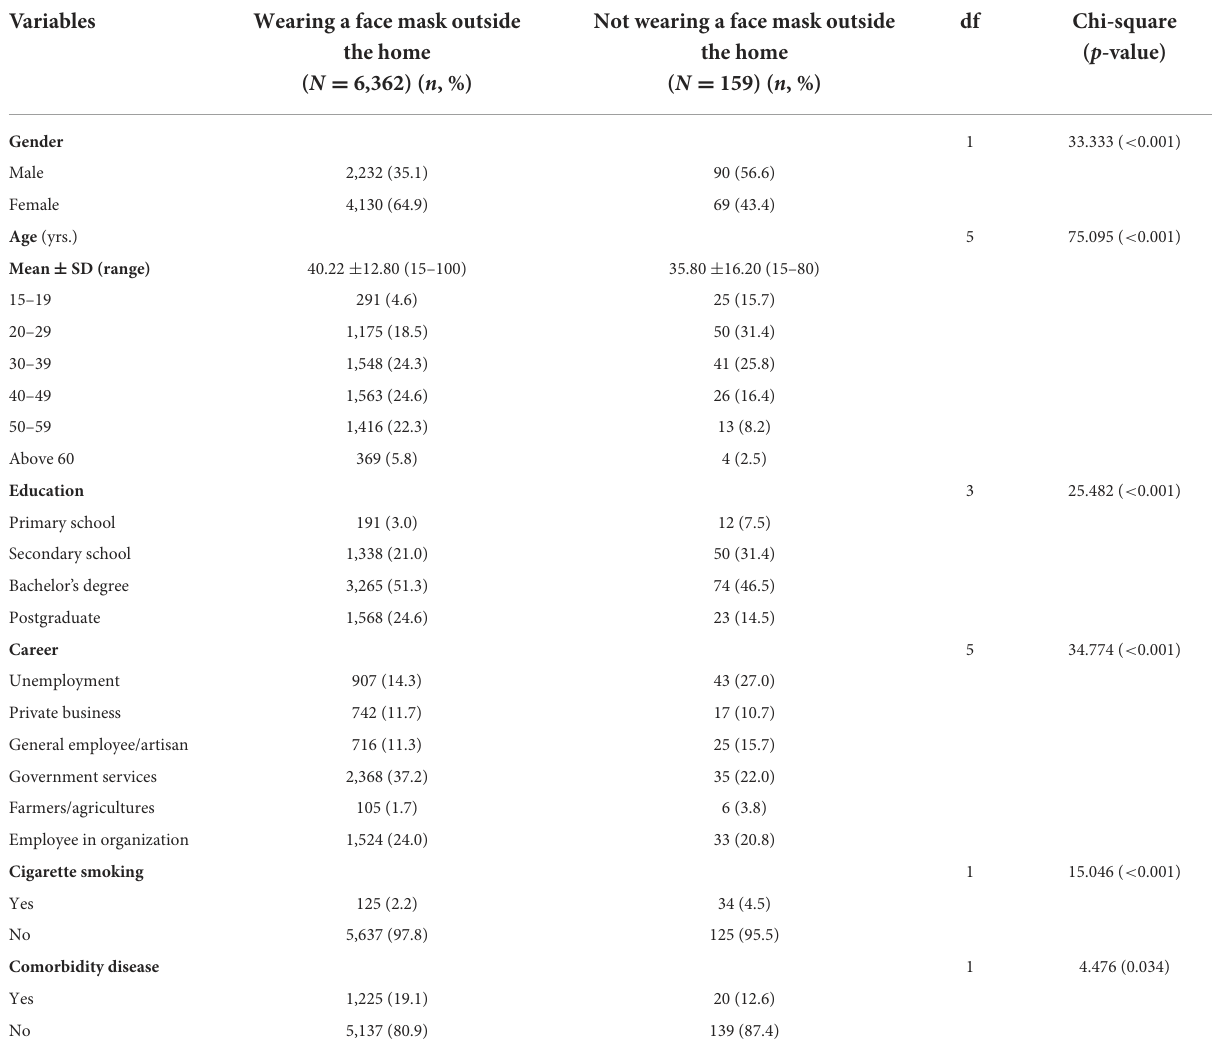
TABLE 1 Frequency, percentage, and chi-square for the categorical explanatory